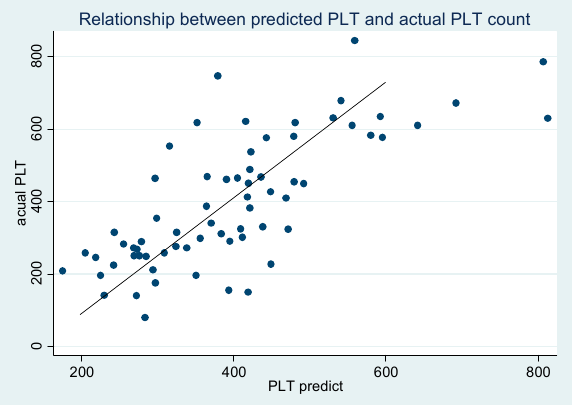
Figure 1. Relationship between predicted PLT and actual PLT. PLT discharge = 16.07 + 0.48 PLT admission + 92.6 Gender male + 3.66 LOS + 92.31 Spleen access + 8.85 WBC − 44.86 Lymph + 9.85 PT.